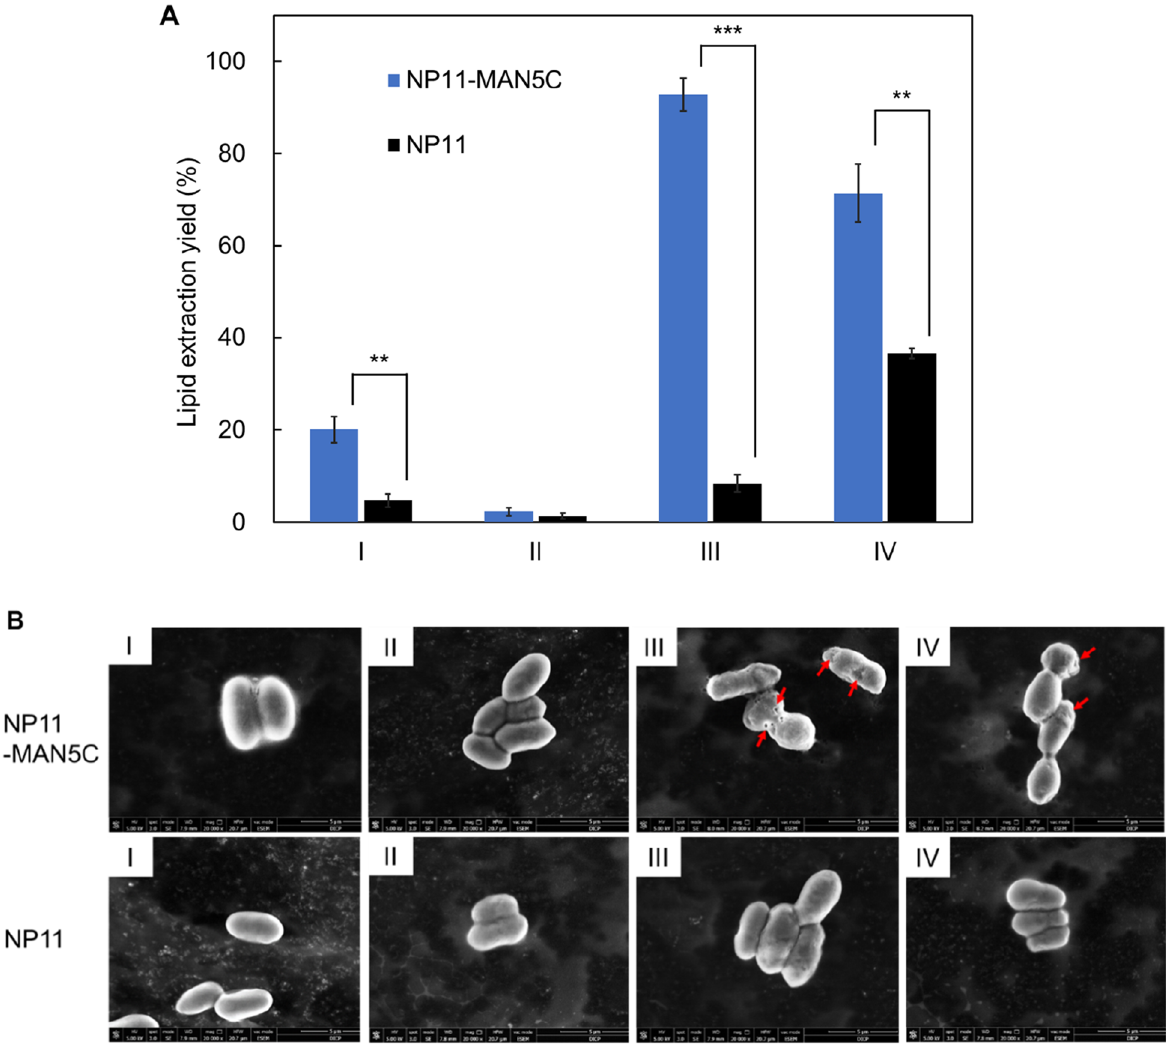
Fig. 4 Lipid extraction yields and cell morphology with different methods. A Lipid extraction yields. Cells were treated according to different methods and then extracted with ethyl acetate at 30 ℃ . B ESEM analysis of R. toruloides cells being treated with different methods. Method I. With no treatment; Method II. Heated in a boiling water bath for 20 min; Method III. Cells were separated, resuspended in water, heated in a boiling water bath for 20 min, separated and then resuspended in the supernatant of the corresponding culture broth; Method IV. Heated in a water bath at 50 ℃ for 24